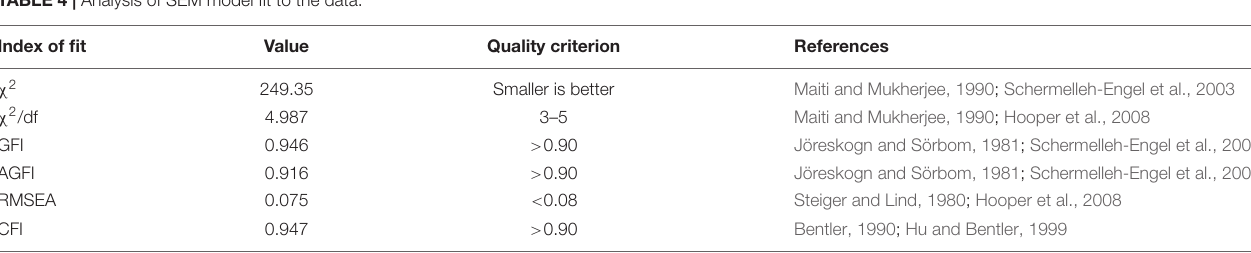
TABLE 4 | Analysis of SEM model fit to the data.